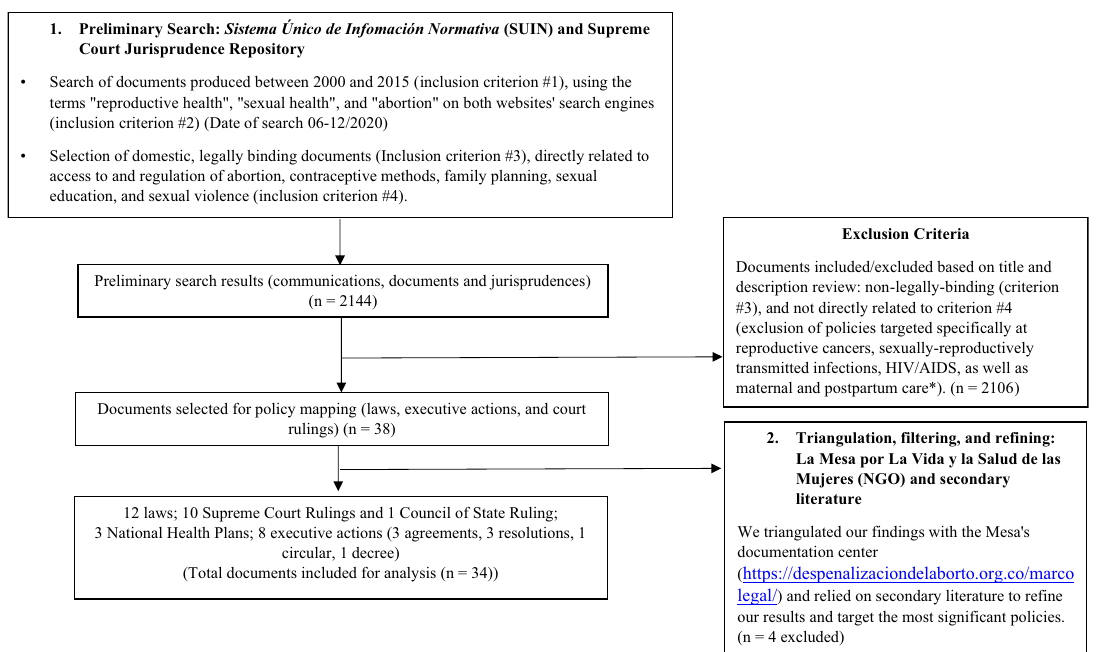
Fig. 1 Two-step search strategy for the policy